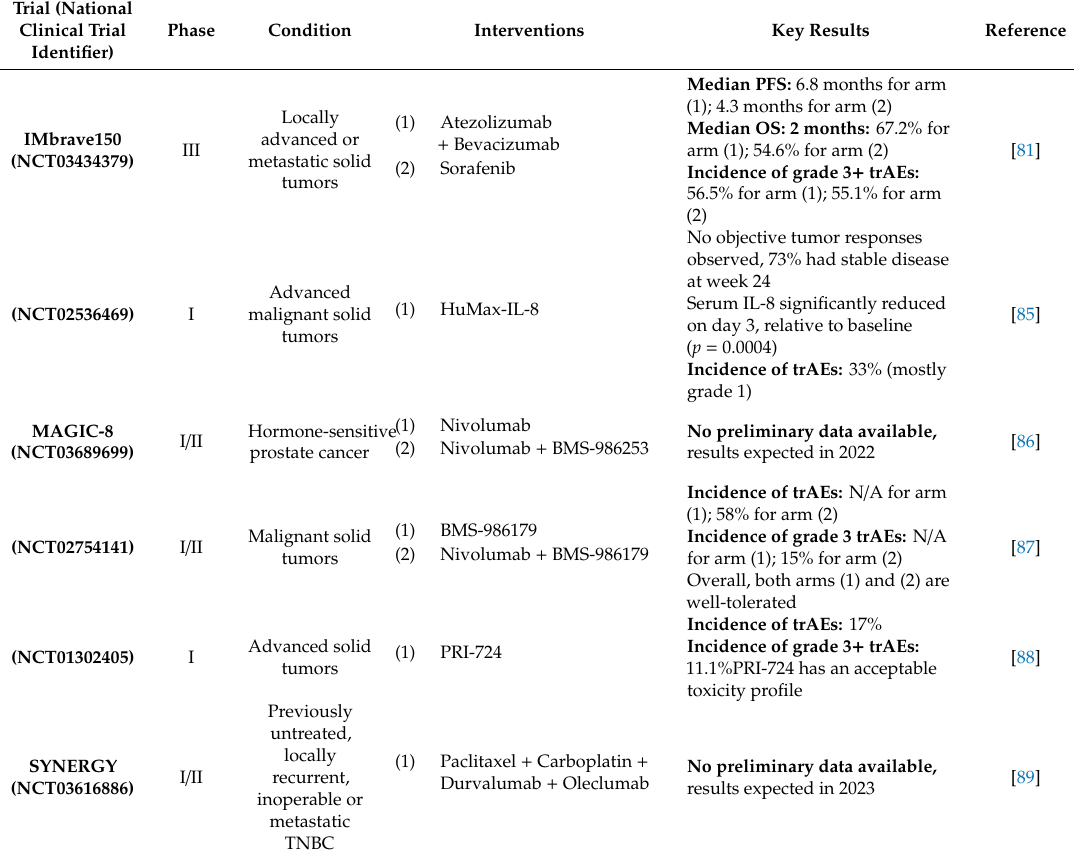
List of completed or ongoing clinical trials using immune checkpoint inhibitors in combinatorial